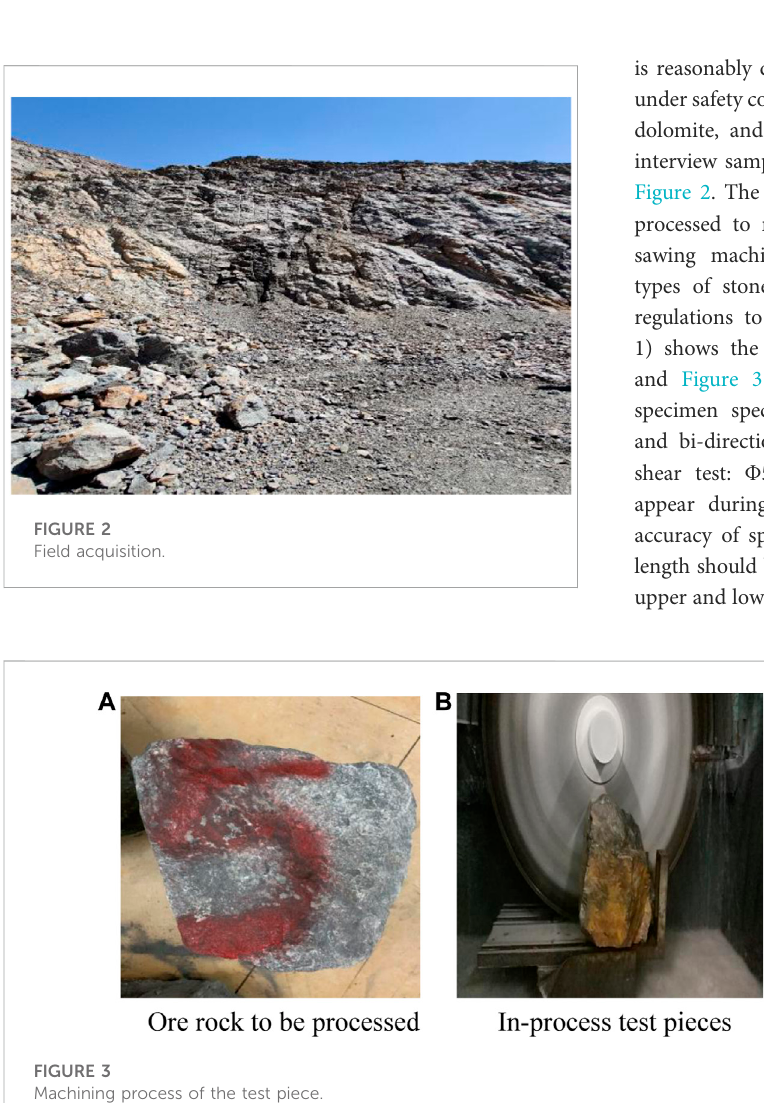
FIGURE 3 Machining process of the test